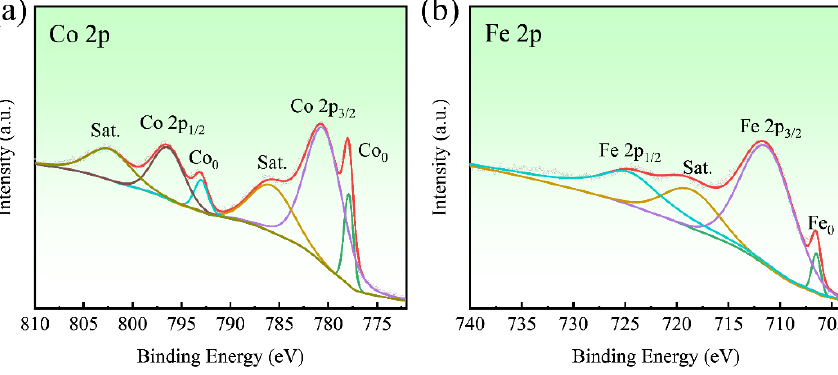
Figure 3. XPS spectra of ( a )Co 2p and ( b )Fe 2p of Fe 35 Co 65 sample.